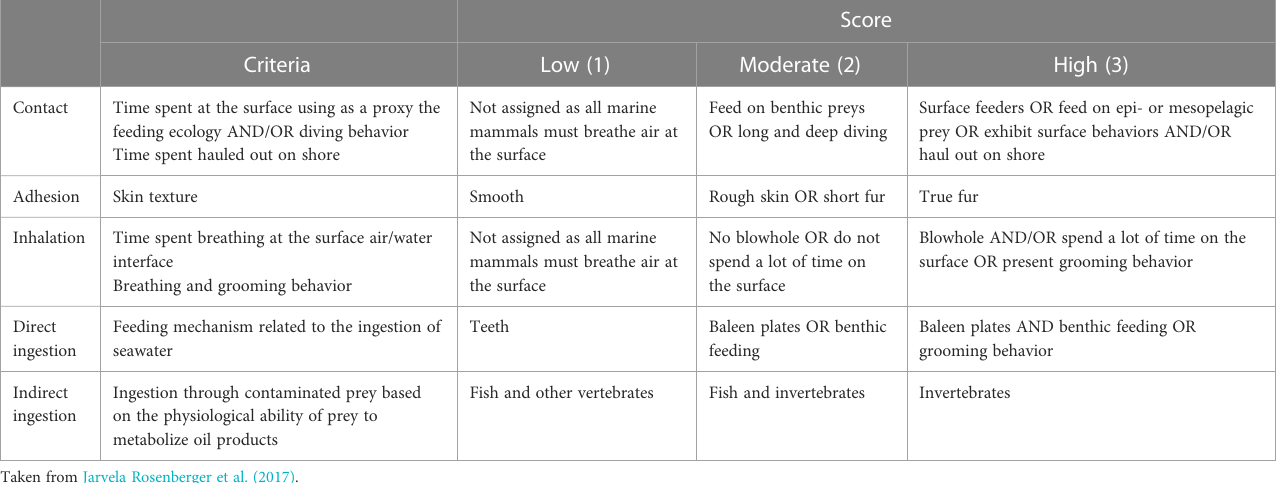
TABLE 1 Exposure pathways based on biological and ecological traits of marine mammals used to estimate the likelihood of exposure ( L ) to